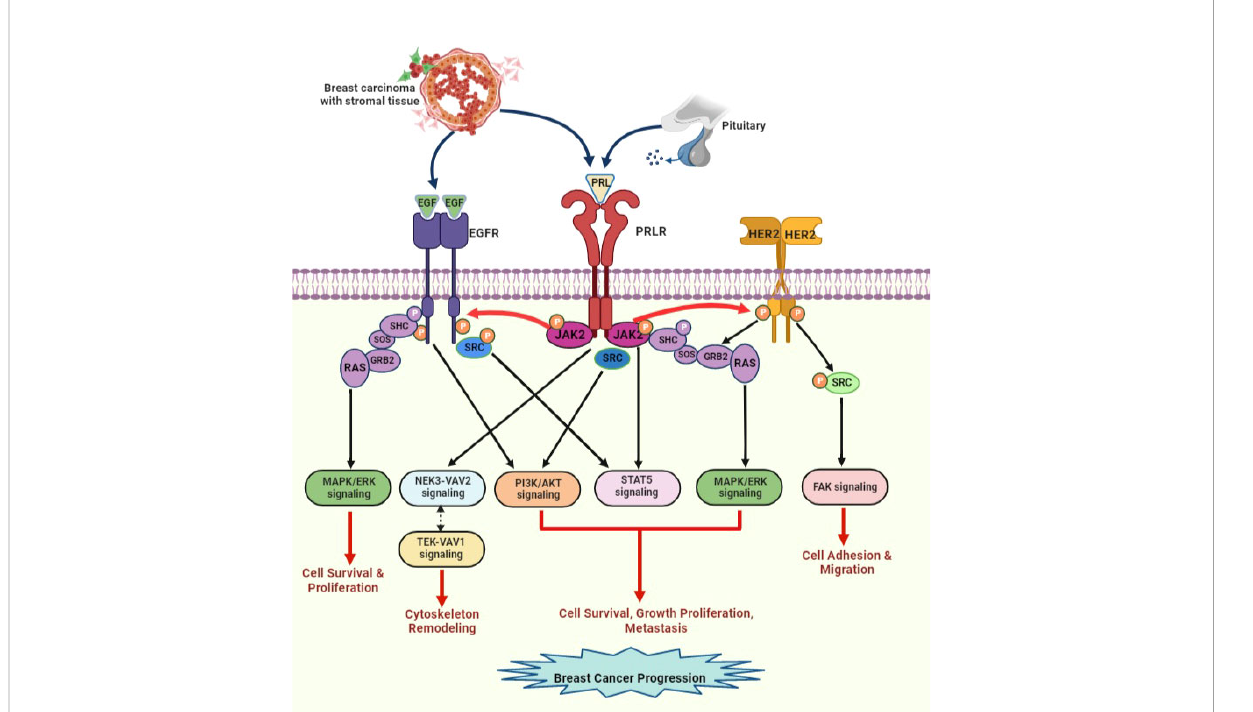
FIGURE 7 PRLR and EGFR/HER2 signaling crosstalk in breast cancer. EGF released by stromal microenvironment surrounding the breast tumor activates signaling cascades that overlap with PRLR signaling cascades upon activation with PRL secreted by breast tumor cells. PRL stimulates HER2 and EGFR signaling pathways via JAK2. EGF/EGFR also activates STAT5 signaling indirectly via s-SRC. This crosstalk between receptors can increase progression of breast tumor and endocrine resistance [adapted from reference